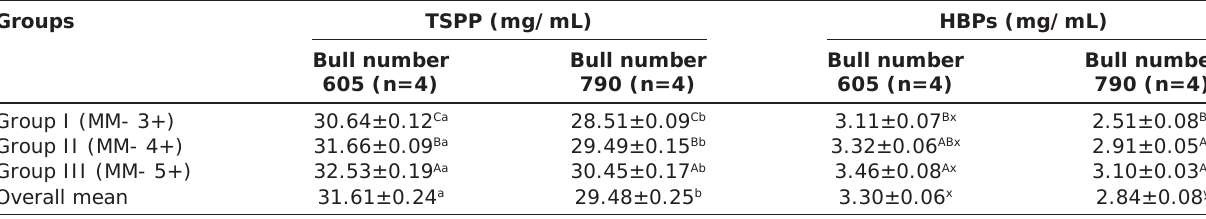
Means bearing different superscripts (a, b and x, y) in a row differ significantly (p<0.01), Means bearing different superscripts (A, B and C) in a column differ significantly (p<0.01). n=number of ejaculates, MM=Mass motility,